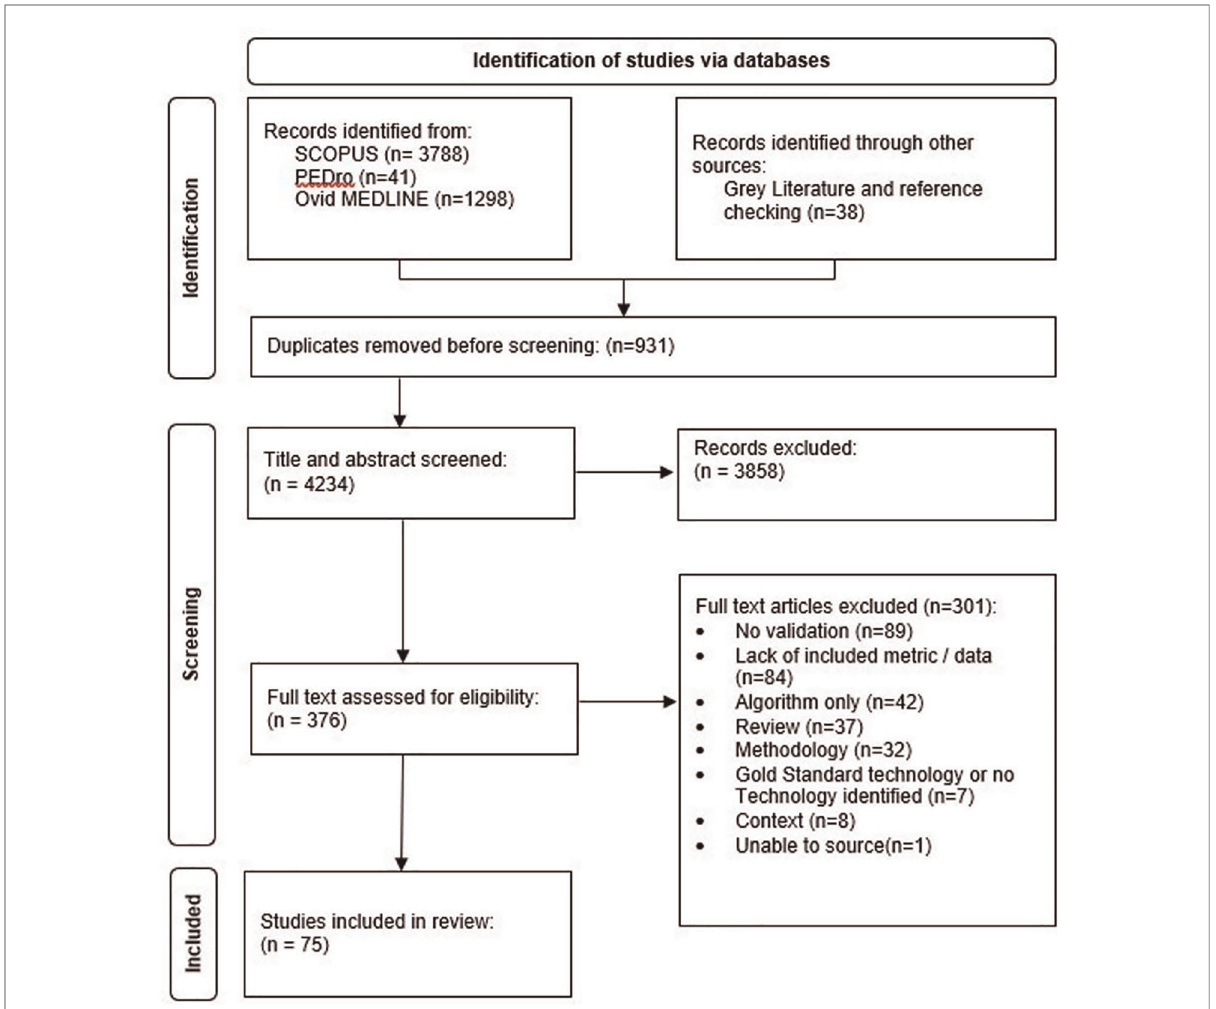
FIGURE 1 PRISMA fl ow diagram (2020) for new systematic reviews included searches from listed databases, registers, and other